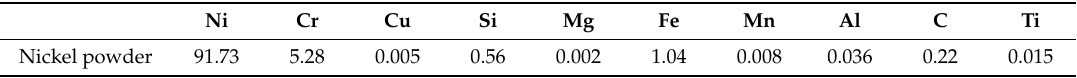
Table 2. Chemical composition of the nickel powder (wt